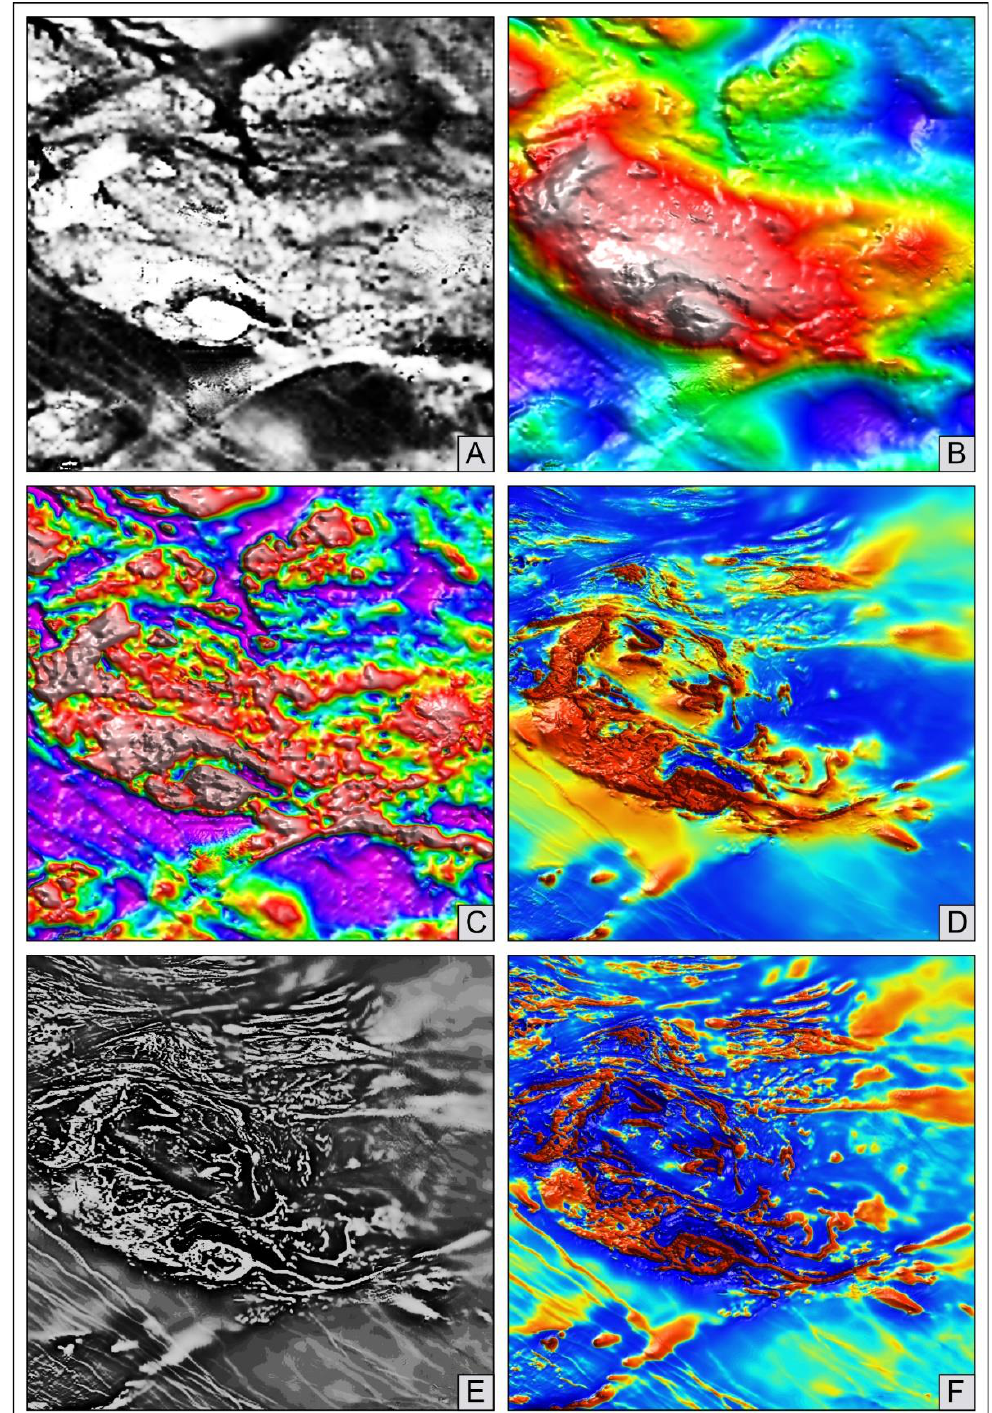
Figure 2. Aeromagnetic and Bouguer gravity datasets used for the structural re-interpretation of the Mt. Woods Inlier (https://map.sarig.sa.gov.au/ (accessed on 27 February 2019)). ( A ) Gravity (WPA- SGRV-EGP) 1st Vertical Derivative; ( B ) Gravity (WPA-SGRV-EGP); ( C ) Gravity UC1000 Residual (WPA-SGRV-EGP); ( D ) Total Magnetic Intensity (TMI); ( E ) TMI Reduced to Pole (RTP) 1st Vertical Derivative; ( F ) TMI RTP UC1000.